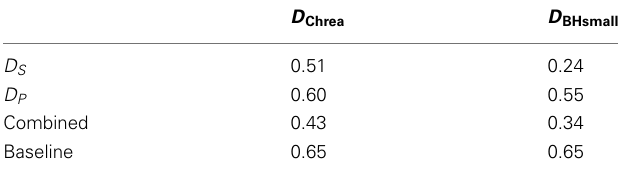
Table 1 |Absolute error of fit between coding spaces ( D P , D S ) and perceptual spaces ( D Chrea and D BHsmall ).